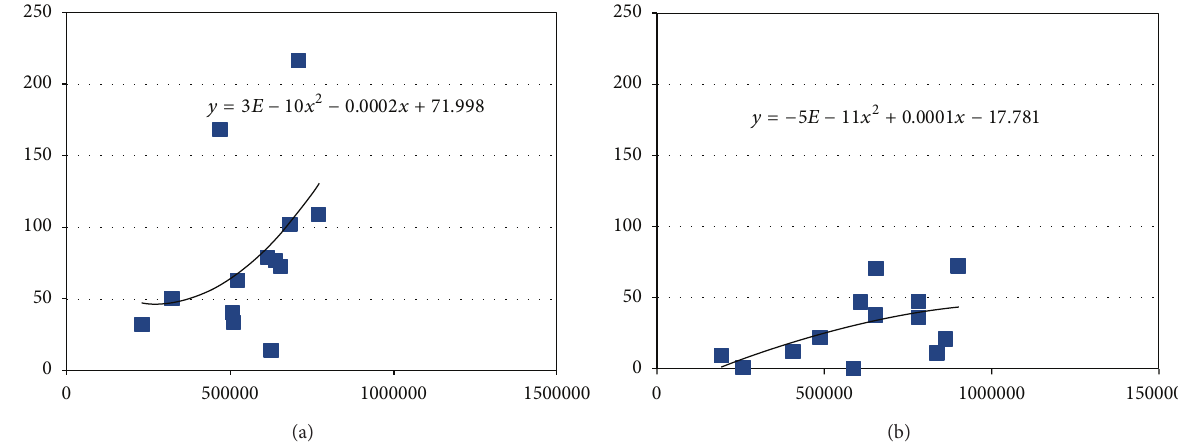
Figure 2: Correlation between the contrast ( 𝐷 value) in the 𝑦 -axis and the area over the veins threshold (pixels) in the 𝑥 -axis, for the Carl Zeiss (a) and the Topcon camera (b).